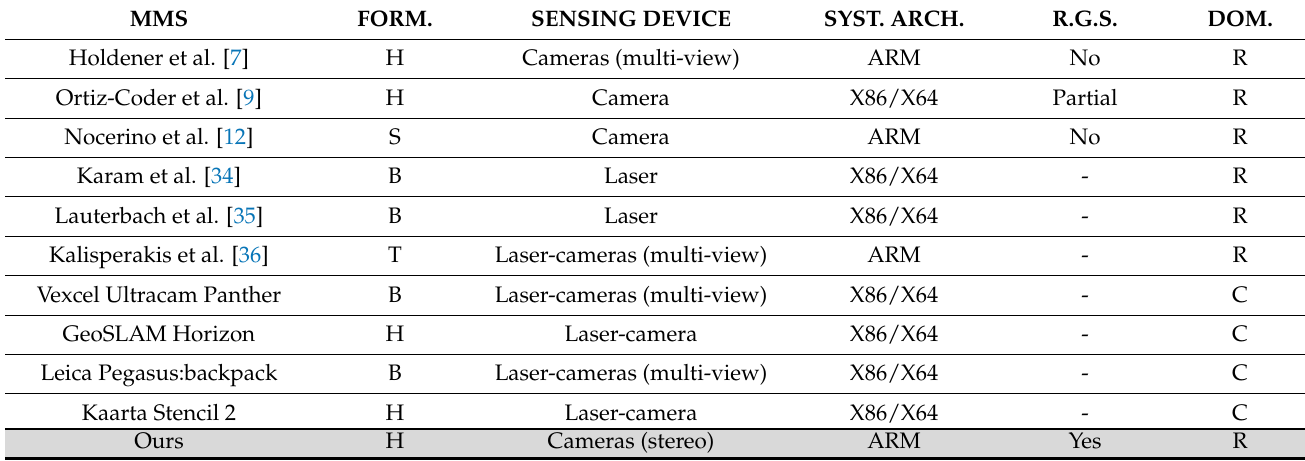
Table 1. Some representative and/or recent portable MMSs in the research (R) and commercial (C) domains (DOM.). They are categorized according to the format (FORM.) as handheld (H), smartphone (S), backpack (B), trolley (T), sensing devices, system architecture (SYST. ARCH.) and presence, in photogrammetry-based systems, of an onboard real-time guidance system